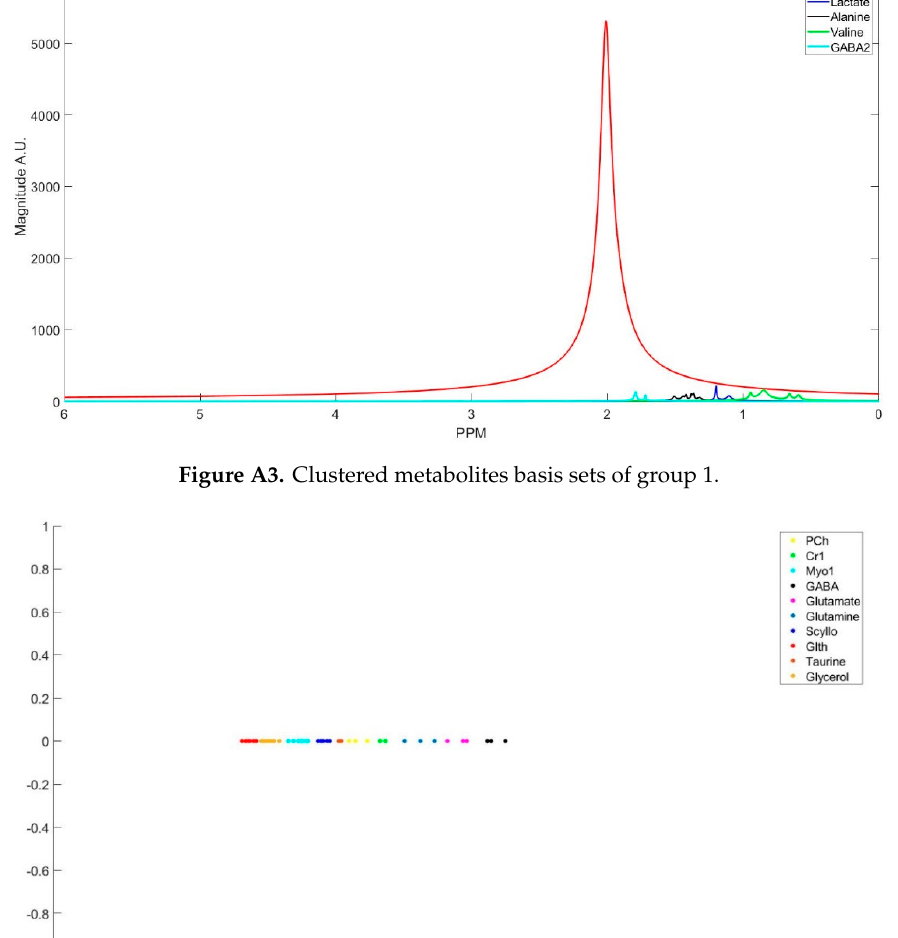
Figure 11. Metabolites listed as group 3 and their corresponding peaks.